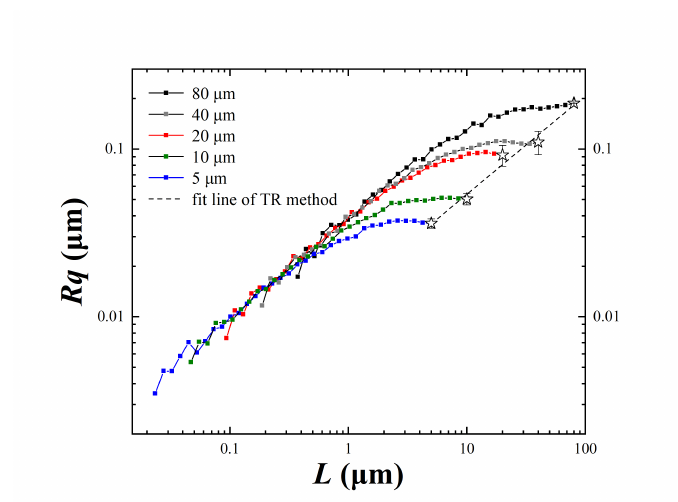
Figure 9. Rq - L curves calculated with RSE-f0 method for the morphological images (512 × 512) with various L , which were extracted from an artificial fractal surface (8192 × 8192) with D i = 2.4. Figure 10 shows that when the sub-images were flattened with order 1 or 2 in the RSE method (RSE-f1 or RSE-f2), the Rq - L curve of the RSE method could overlap with that of the TR method, in which the same flatten order was utilised for all the as-measured images. The Rq - L curves of RSE-f1 and RSE-f2 were generally linear within a broad L region of two orders of magnitude.